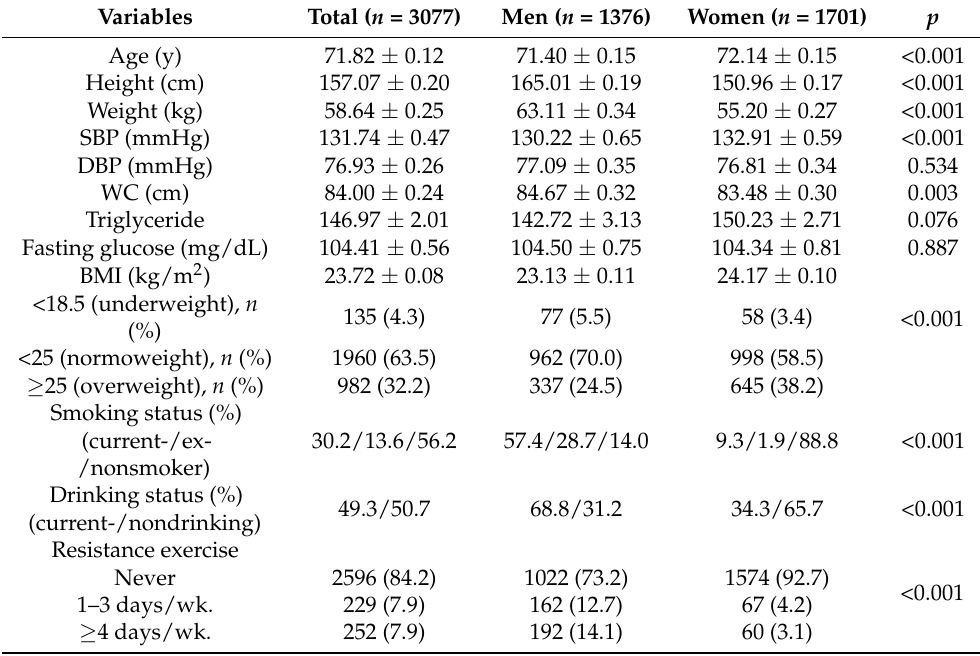
Table 1. General characteristics of participants by